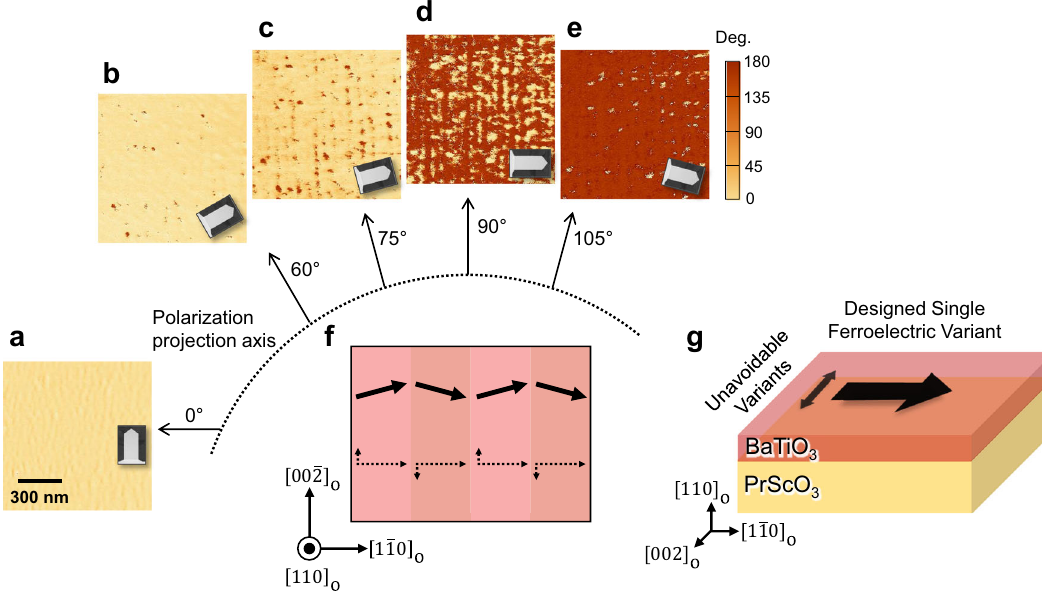
Fig. 5 Angular dependent lateral PFM images and an overall in-plane polarization con fi guration. a – e Lateral PFM phase images with various relative sample-cantilever arm angles of 0° ( a ), 60° ( b ), 75° ( c ), 90° ( d ), and 105° ( e ). The inset shows the orientation of the cantilever with respect to the crystallographic directions of the PSO substrate. Note that the angle is de fi ned by the angle between the polarization projection axis and PSO ½ 1 (cid:1) 10 (cid:2) O direction. f In-plane domain structure constructed from PFM images of a – e . The dashed arrows show two orthogonal in-plane components of in-plane polarization (solid arrows), g , Overall con fi guration of in-plane polarization in the BTO fi lm. Designed single ferroelectric variant is achieved along PSO h i ½ 1 (cid:1) 10 (cid:2) O direction, while there are unavoidable extra variants along PSO 002 O directions due to absence of suitable single crystal domain structure (Fig. 5f). The polarization rotation in as-grown state results in non-linear and weak hysteresis behavior in P-E loop with applying electric fi eld along the PSO 002 ½ (cid:2) direction O (Fig. 4c). The origin of non-zero polarization along the PSO direction is further supported by phase fi eld simulation 002 ½ (cid:2) O where pure in-plane single-domain state is achieved by simply eliminating tensile strain along the PSO 002 ½